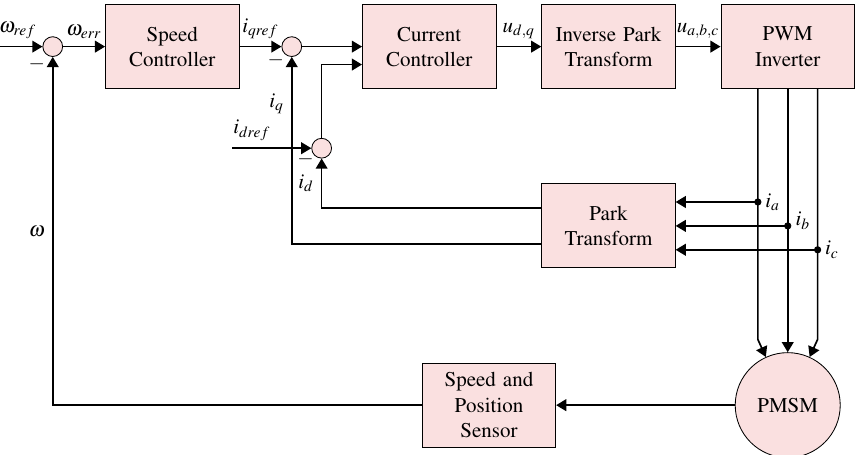
Figure 14. Field oriented control block diagram for speed control in